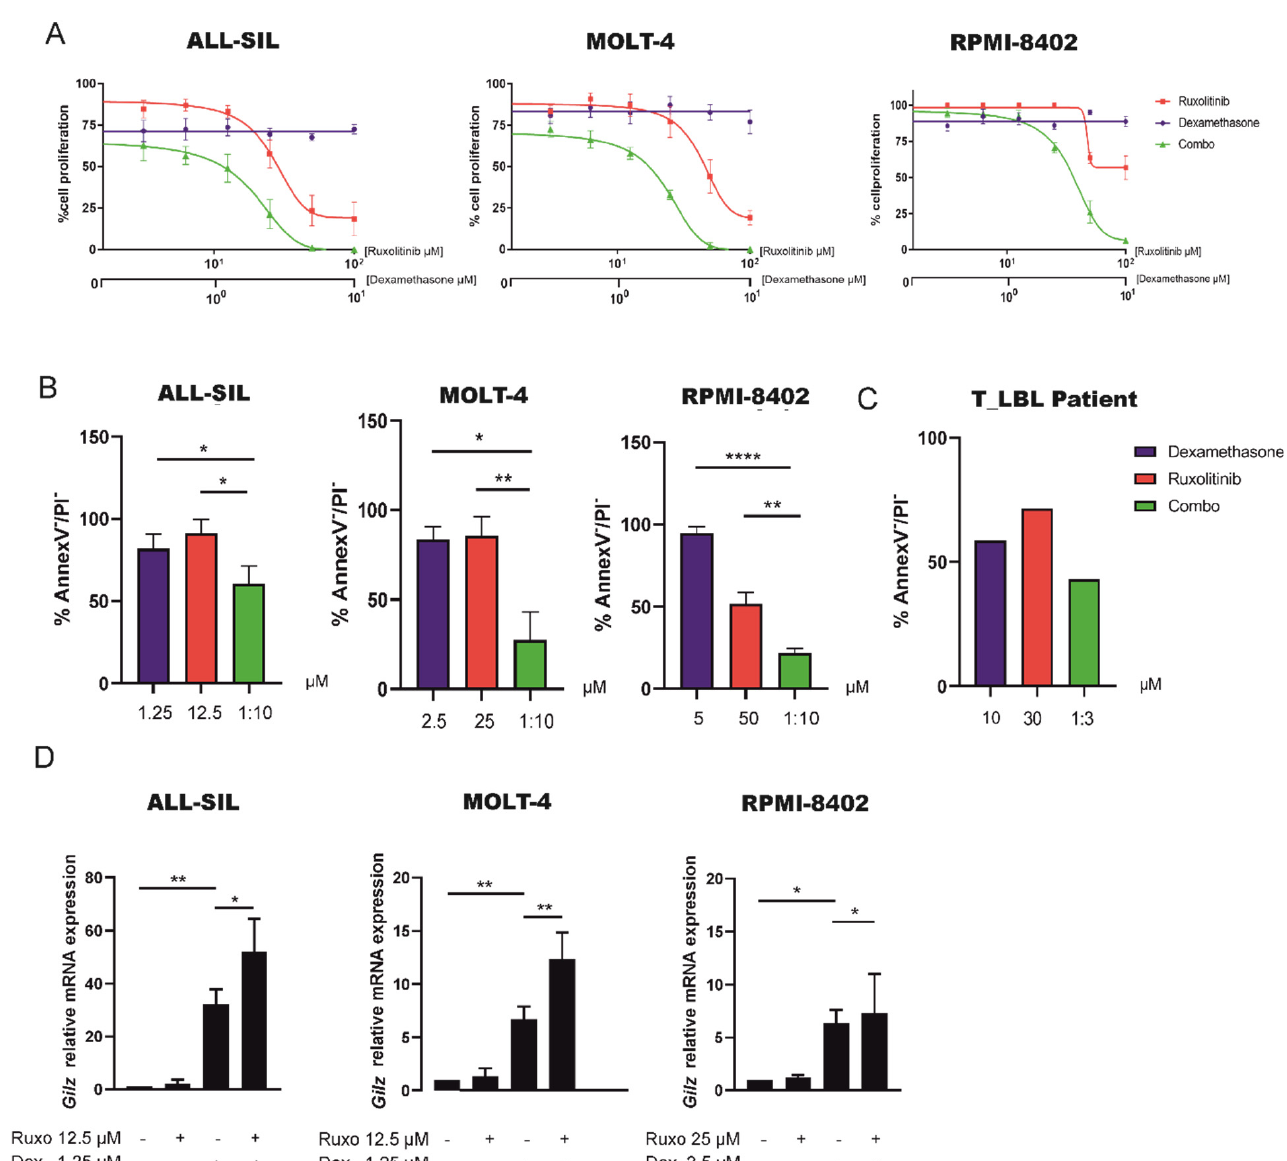
Figure 5. Pharmacological inhibition of JAK1/2 kinases decreases cell proliferation and increases dexamethasone induced cell death in GC resistant leukemia cells. ( A ) ALL-SIL, MOLT-4, and RPMI-8402 cells treated with dexamethasone and ruxolitinib alone or in combination. All the three cell lines were treated at the molar ratio (ruxolitinib: dex) of 10:1 and cell proliferation was determined by MTT test after 72 h of treatment ( n = 3 at least for all experiments). Results are presented as means ± SEM. ( B ) Cell mortality was determined by flow cytometry and annexin V/PI staining after 72 h of treatment. The percentage of dead cells was established after normalizing cells on DMSO-treated cells. (Paired t test; n = 3 for all experiments). Results are presented as means ± SEM. Dexamethasone and ruxolitinib concentrations used in these experiments were selected based on MTT test results. ( C ) Primary cells isolated from one T-LBL patients were treated with dexamethasone (10 µ M) and ruxolitinib (30 µ M) alone or in combination for 48 h. Cell mortality was determined by flow cytometry and annexin V/PI staining. The percentage of dead cells was established after normalizing cells on DMSO treated cells. ( D ) GR transcriptional activity measured by GILZ mRNA levels in ALL-SIL, MOLT-4 and RPMI-8402 cells treated with DMSO, dexamethasone (ALL-SIL and MOLT-4 1.25 µ M; RPMI-8402 2.5 µ M) or ruxolitinib (ALL-SIL and MOLT-4 12.5 µ M; RPMI-8402 25 µ M) alone or in combination. Results are presented as means ± SEM (* p < 0.05; ** p < 0.01; **** p < 0.0001. paired t test).